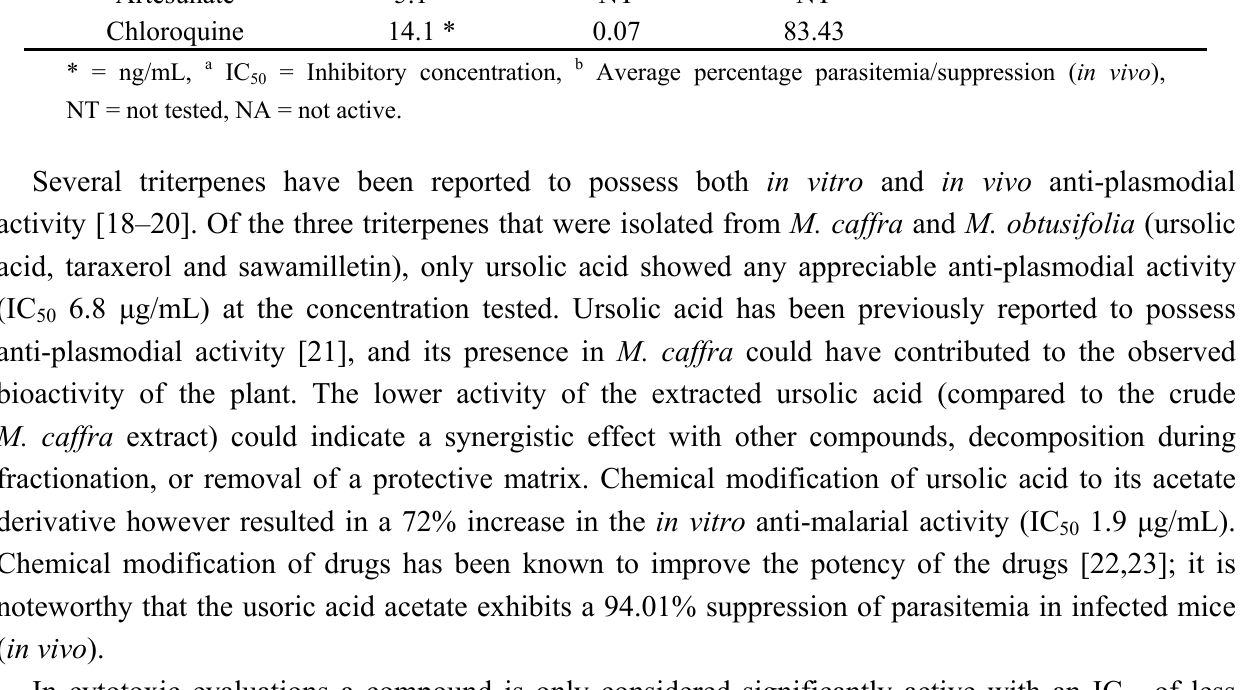
a Cytotoxicity ( μ g/mL) a IC b Average % b Average % 50 (µg/mL) parasitemia suppression